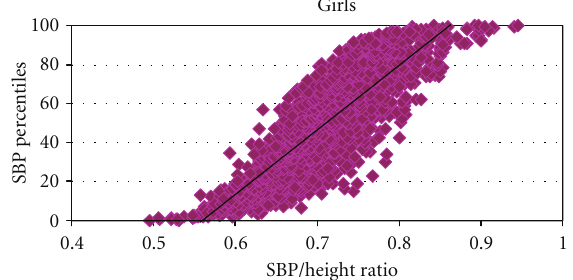
Figure 2: The graph depicts the strong correlation of systolic blood pressure percentiles (SBP Percentiles), on the Y Axis and the systolic blood pressure over Height ratio (SBP/height ratio) on the X Axis in girls P < 0 . 001, R 2 = 0 . 80. SBP: Systolic Blood